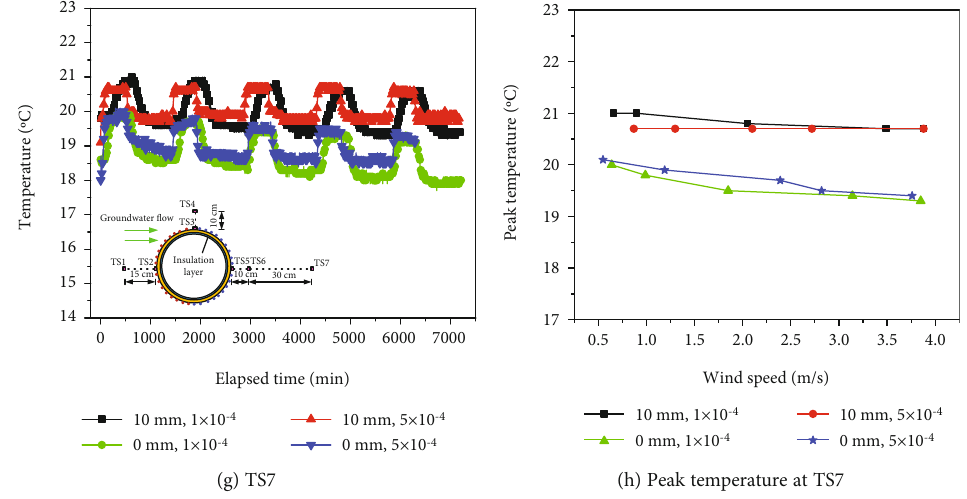
Figure 8: In fl uence of the insulation layer on the surrounding rock temperature variation trend at di ff erent locations.